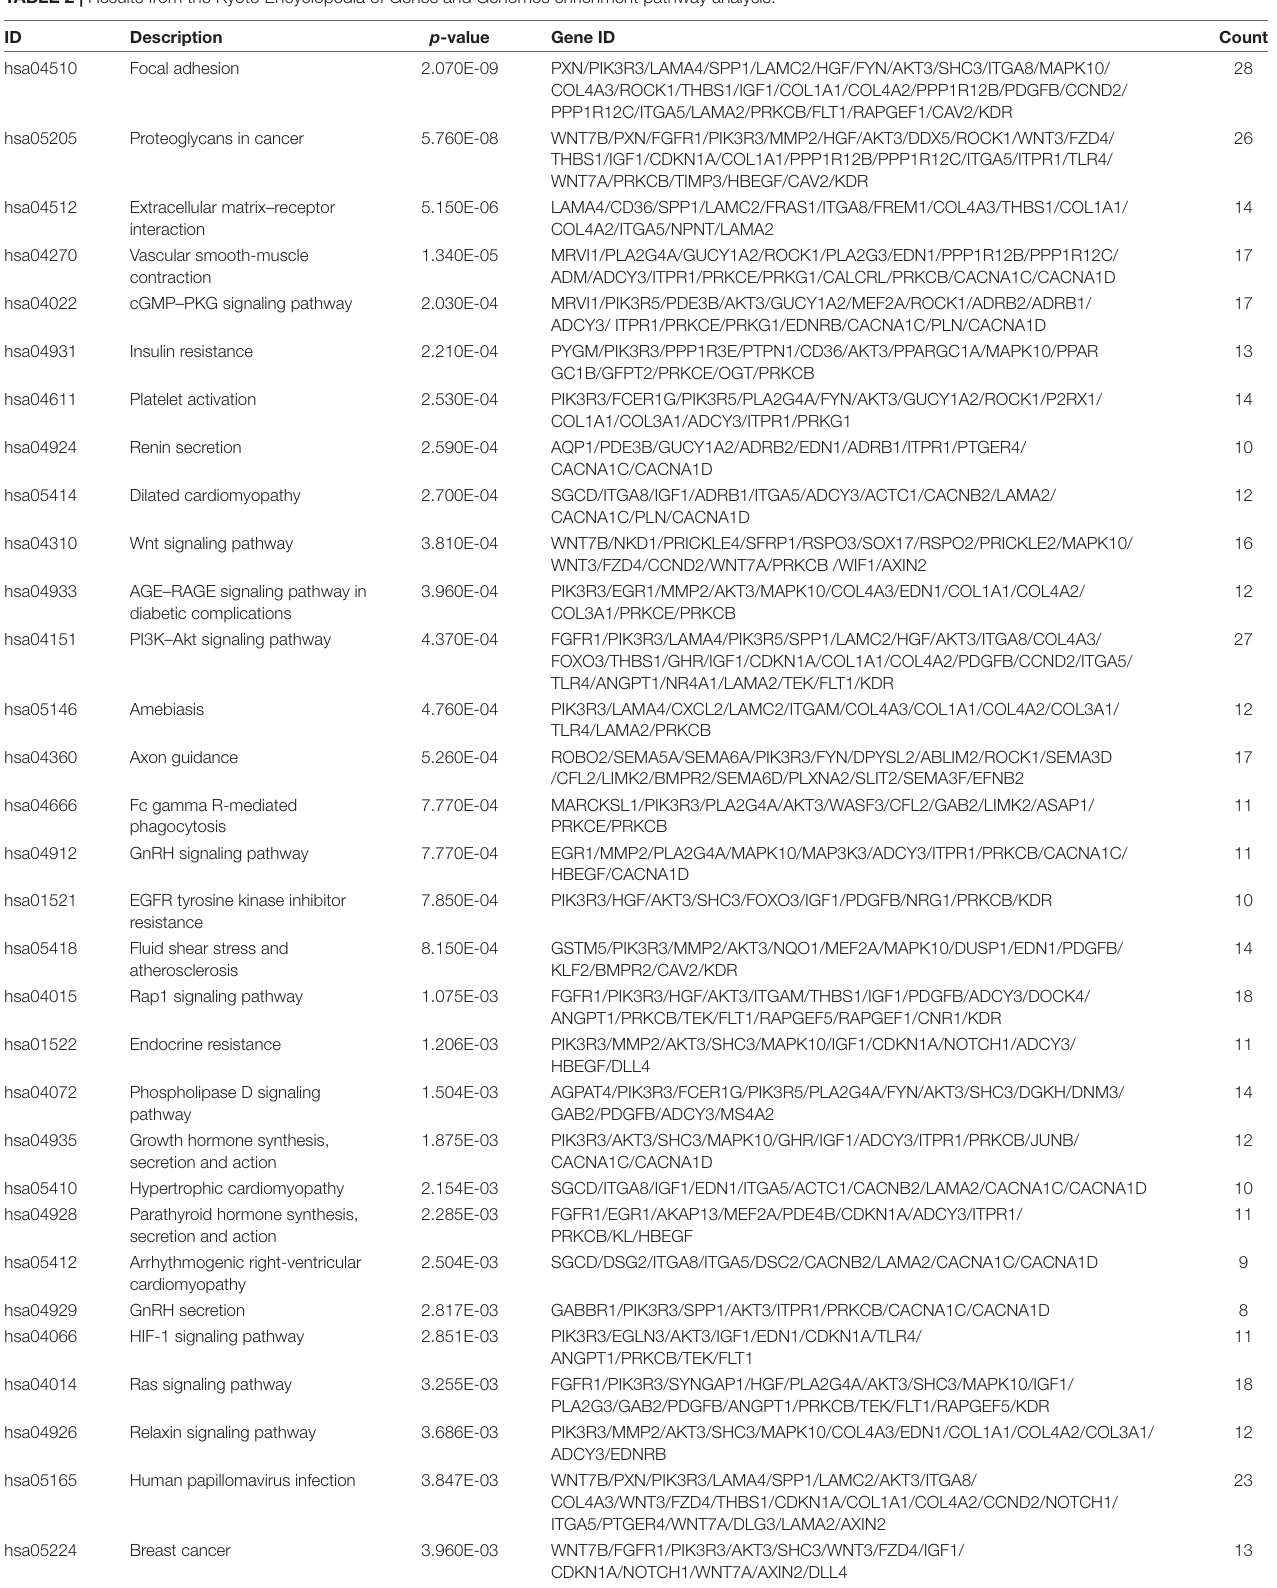
TABLE 2 | Results from the Kyoto Encyclopedia of Genes and Genomes enrichment pathway